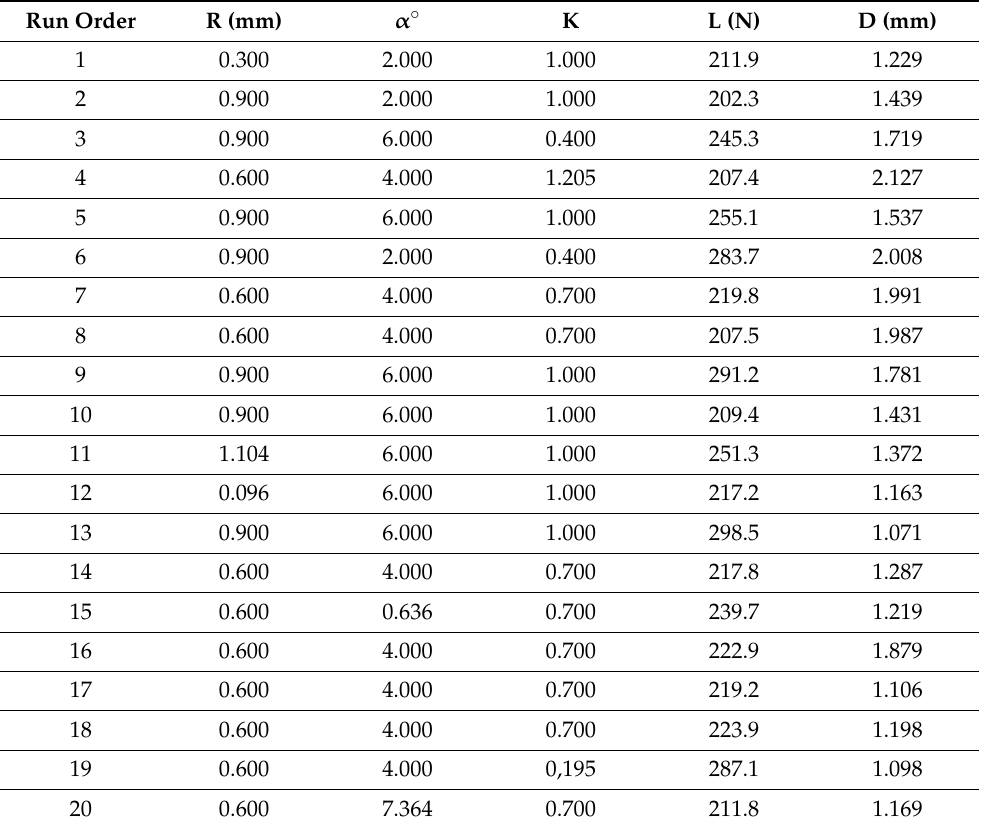
Table 7. Force (F) and displacement (D), obtained by testing artificially aged parts. Run Order R (mm) α